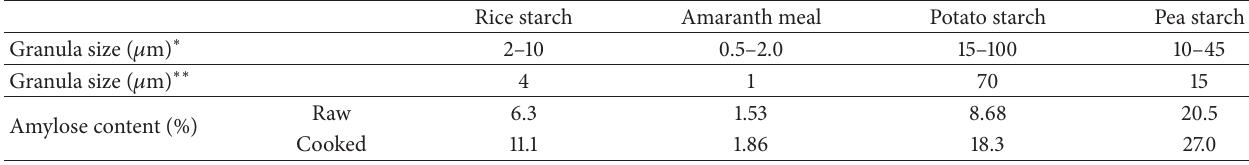
Table 1: Granula size and amylose content (%) of starch sources used in this